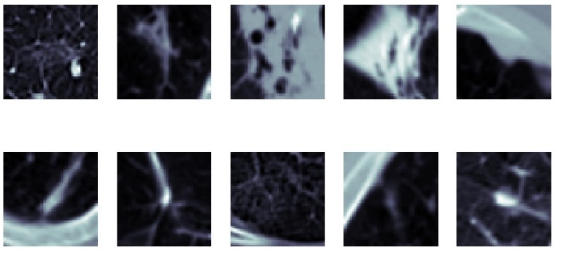
Figure 20. SFMPF model based on Bilateral image—missed non-nodules (FP).